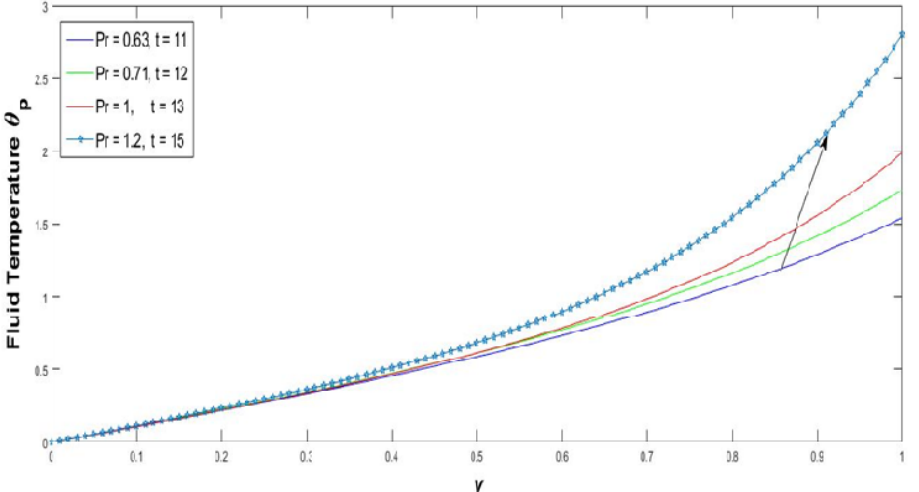
Figure 22. Temperature field for various Prandtl